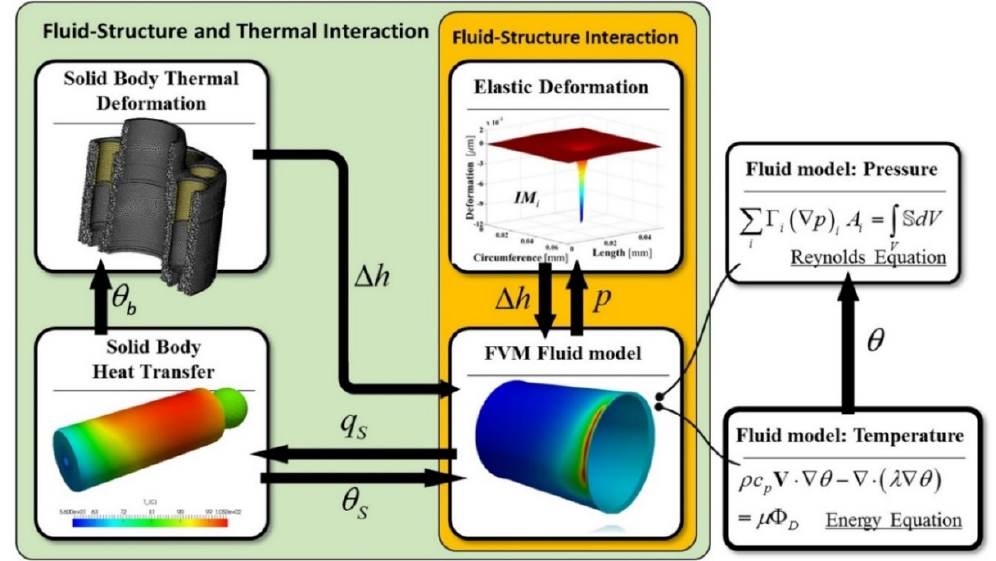
Figure 4. Structure of the simulation model for the prediction of lubricating interface performance.